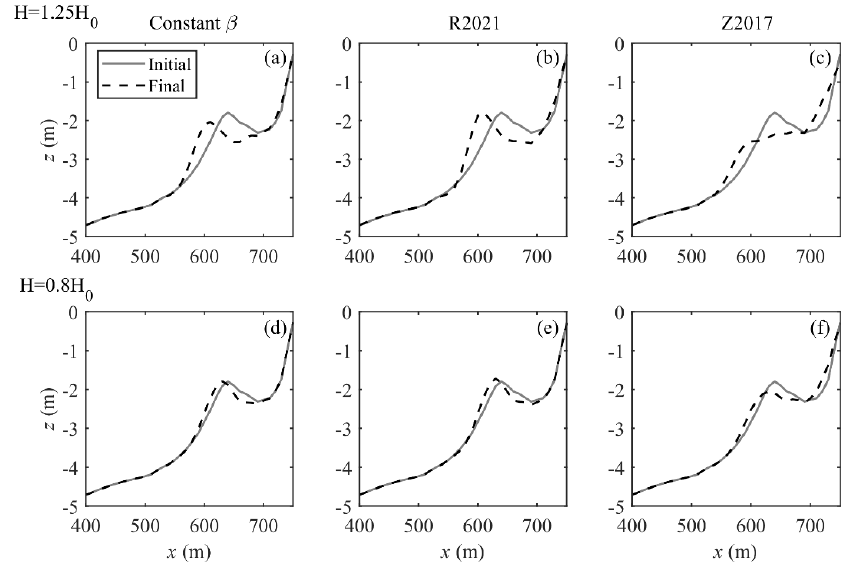
Figure 5. Comparisons of beach profile predicted by constant roller slope ( a , d ), roller slope of R2021 ( b , e ) and Z2017 ( c , f ) under two different wave heights. Figure 5a–c are calculated with H = 1.25 H 0 , and Figure 5d–f are calculated with H = 0.8 H 0